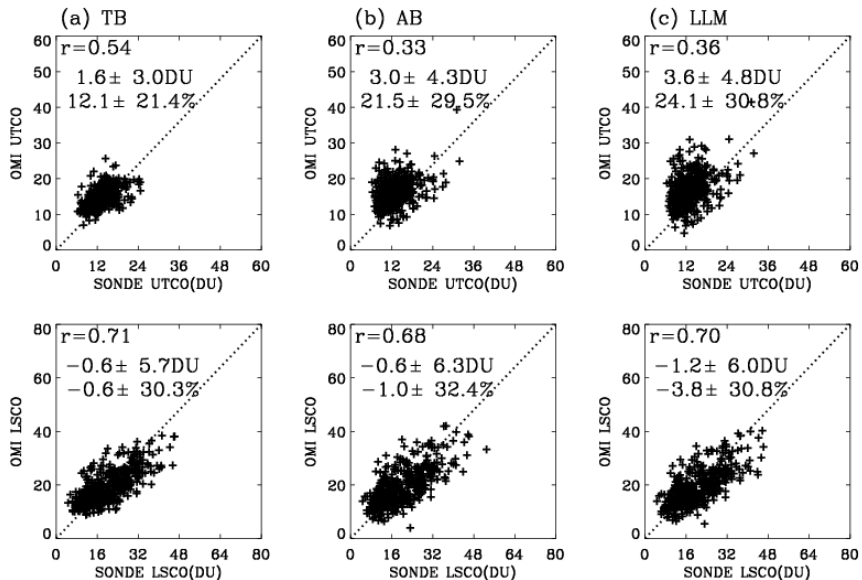
Figure 10. Upper panels: ozonesonde upper tropospheric column ozone (UTCO) vs. OMI retrievals at Hohenpeißenberg during 2004–2008. The upper tropospheric region ranges from − 5 to 0km relative to the tropopause. The bottom panels are the same as the upper panels, except for showing lower stratospheric column ozone (LSCO) within 3km of the tropopause. The 1:1 lines (dotted lines) and the correlation coefficients (r) are shown. We also give the mean biases and 1 σ standard deviations for absolute and relative differences defined as 2(OMI − sonde)/(OMI + sonde) × 100, respectively. Note that the ozonesonde profiles are not convolved with OMI averaging kernels.